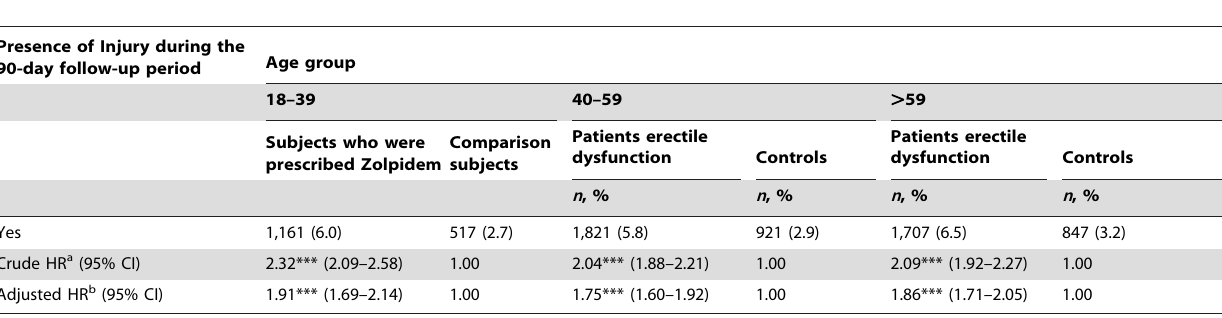
Table 4. Incidence rate, crude and adjusted hazard ratios for injury among the sampled subjects by age group.